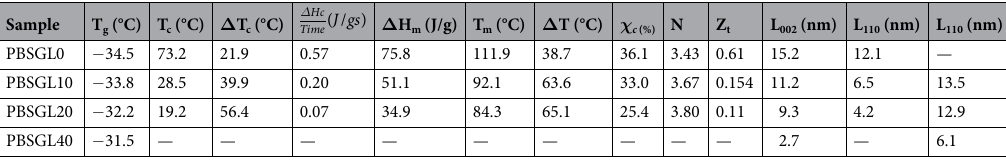
Table 2. DSC and XRD results of the PBSGL n co-polyesters.